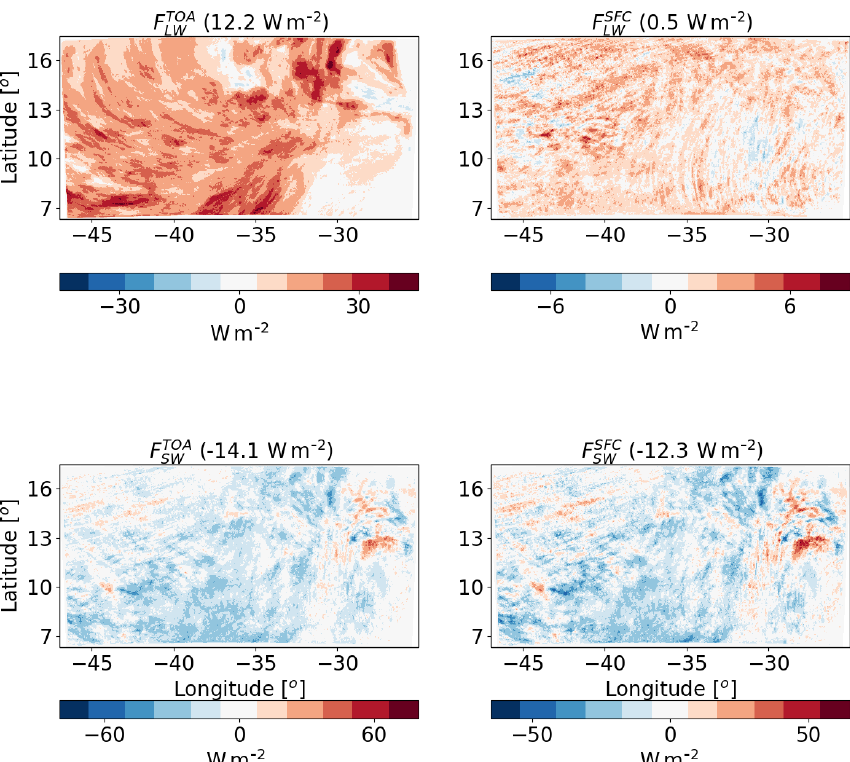
Figure 15. The differences between polluted (CDNC = 200cm − 3 ) and clean (CDNC = 20cm − 3 ) ICON simulations of the time-mean radiative longwave (LW) and shortwave (SW) fluxes at the top of atmosphere (TOA) and surface (SFC) for the deep-cloud-dominated case (16–18 August 2016). The domain- and time-mean value of each term appear in